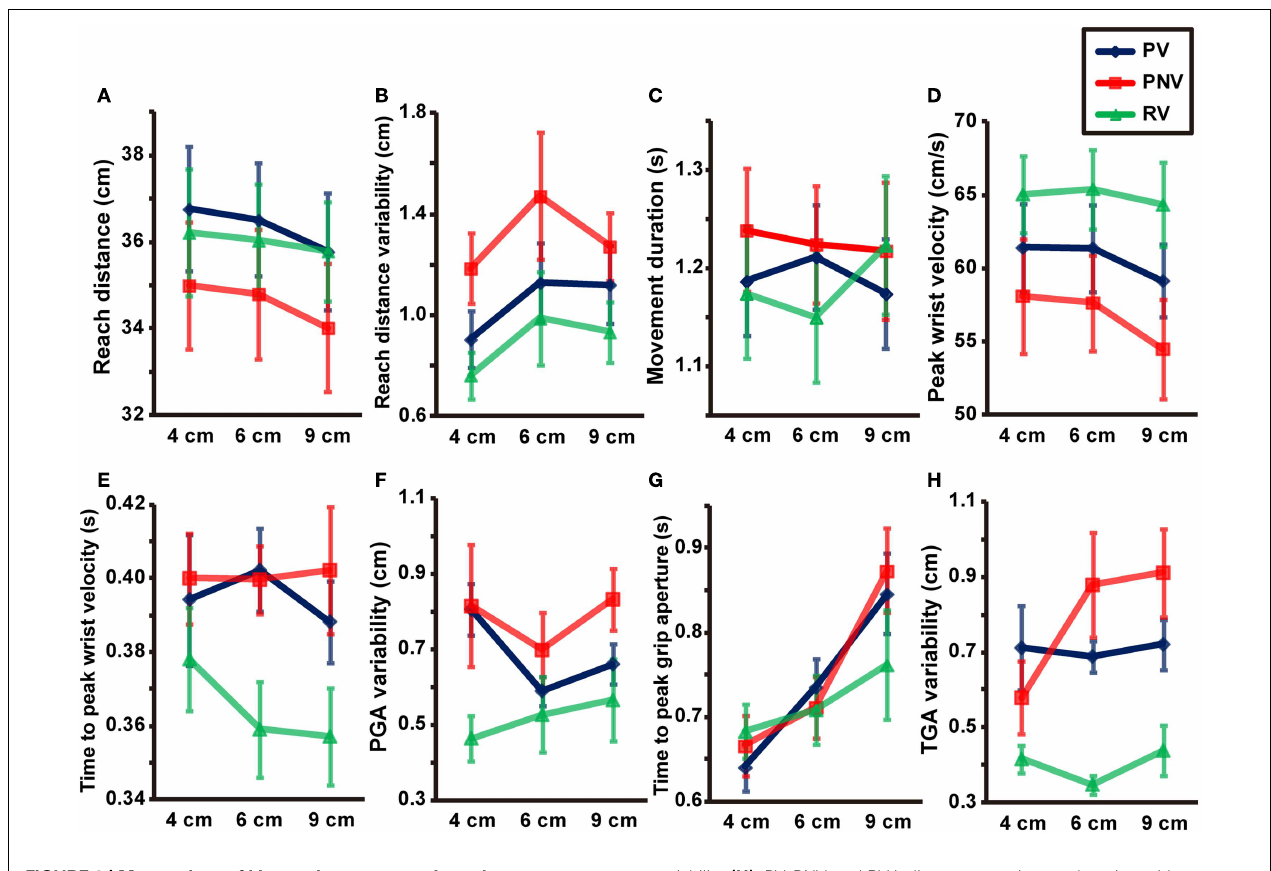
FIGURE 2 | Mean values of kinematic parameters in each condition. Reach distance (A) , reach distance variability (B) , movement duration (C) , peak wrist velocity (D) , time to peak wrist velocity (E) , PGA variability (F) , time to peak grip aperture (G) , andTGA